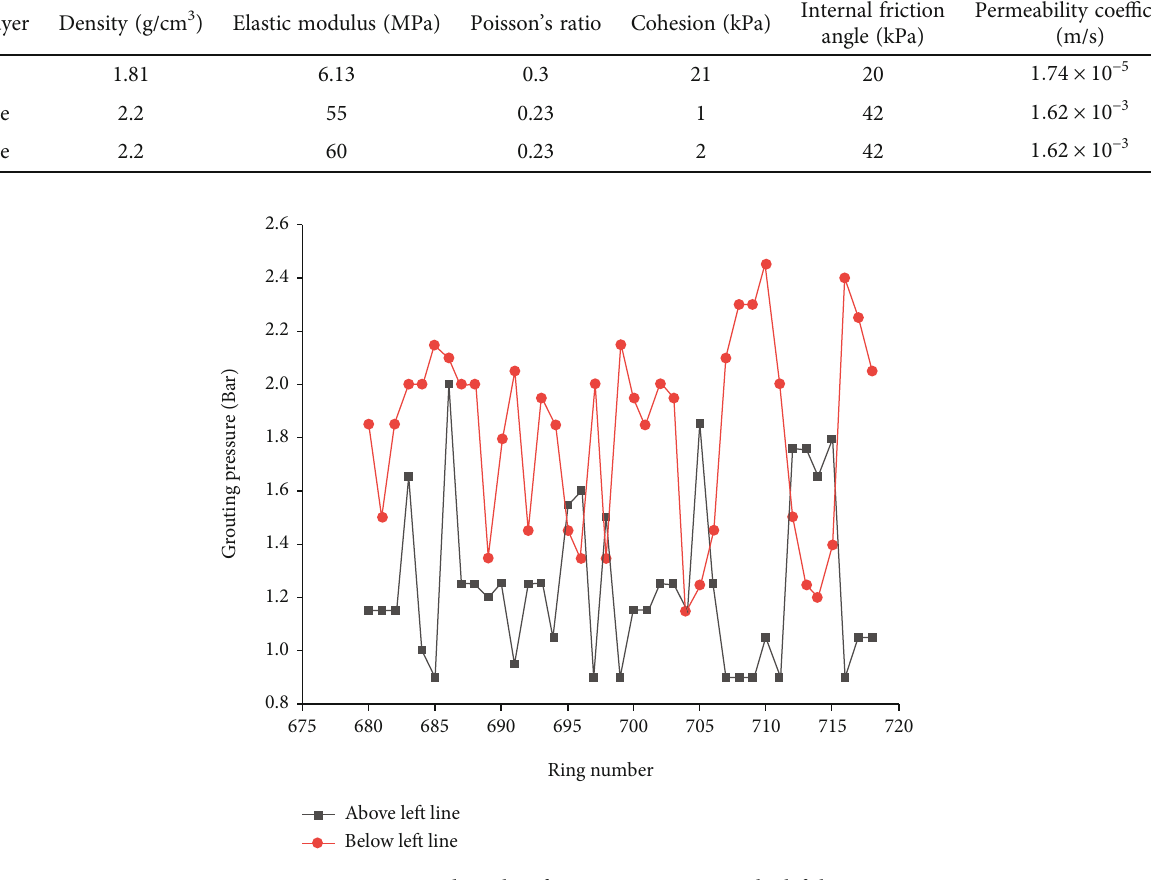
Figure 3: Measured results of grouting pressure on the left